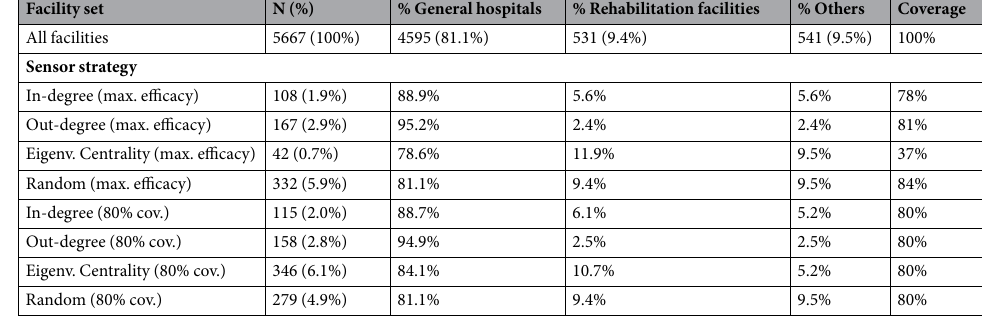
Table 2. Configuration of optimal sensor sets. The table describes the characteristics of the optimal sensor sets (percentage of the total number of facilities, percentage of genera/rehab/other facilities) and the coverage of cases. The optimal sensors, depending on the strategy, are compared both at maximum efficacy and at an 80% coverage